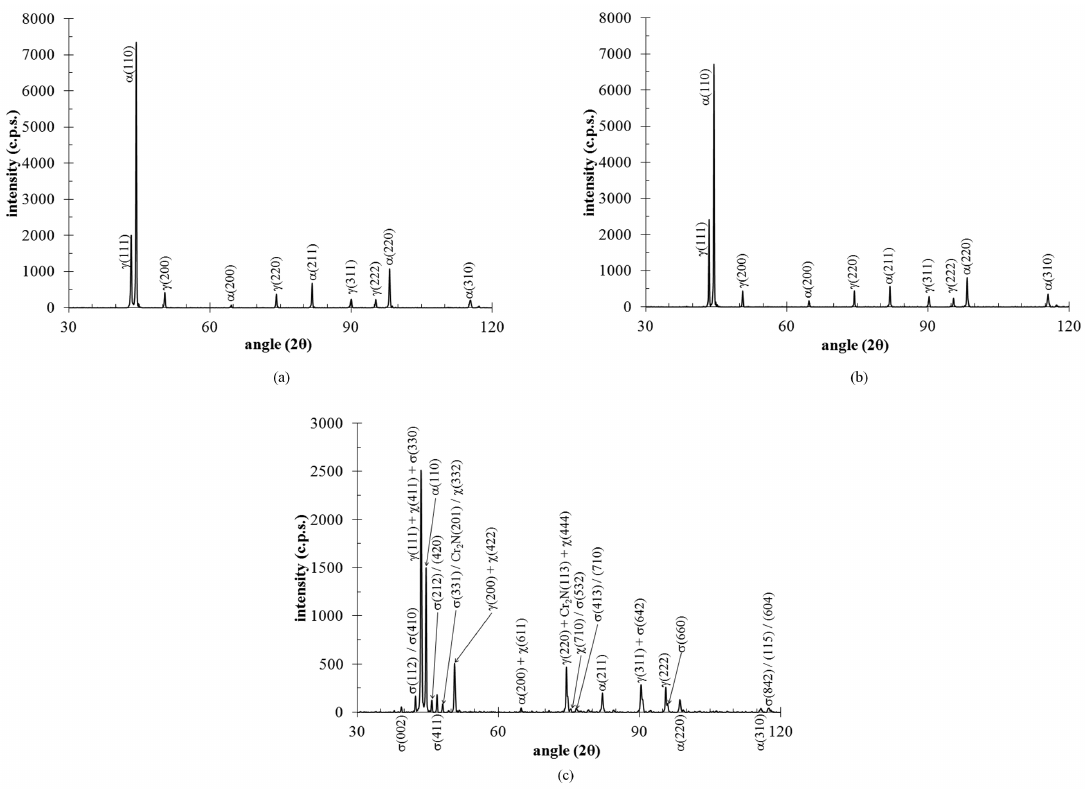
Figure 2. X-ray diffraction patterns of the UNS S31803 studied: (a) solution treated sample, (b) sample aged 4 h at 650°C and (c) sample aged 360 h at 650°C. Ferrite, austenite, sigma, chi and chromium nitride peaks are represented by α , γ , σ , χ and Cr